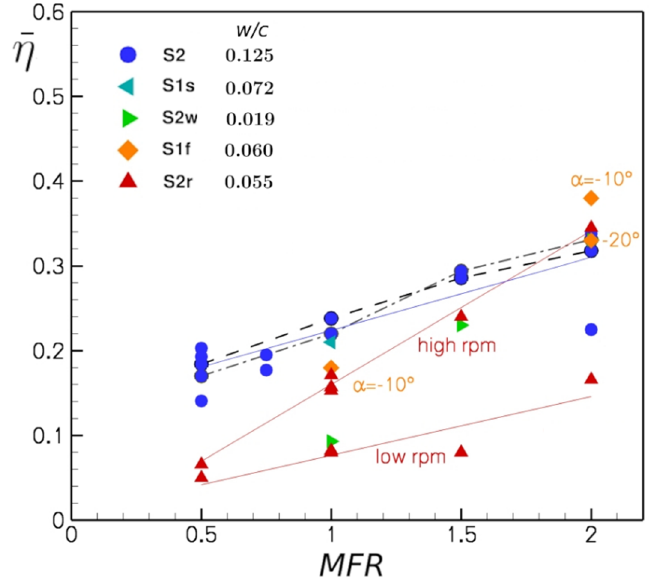
Figure 12. Platform rotor blade film cooling effectiveness (extracted at x/C ax = 20%) as a function of the mass flow ratio with density ratio DR = 1 (S2 [13–15,19], S1s [16], S2w [20], S1f [22], S2r [29,30]).